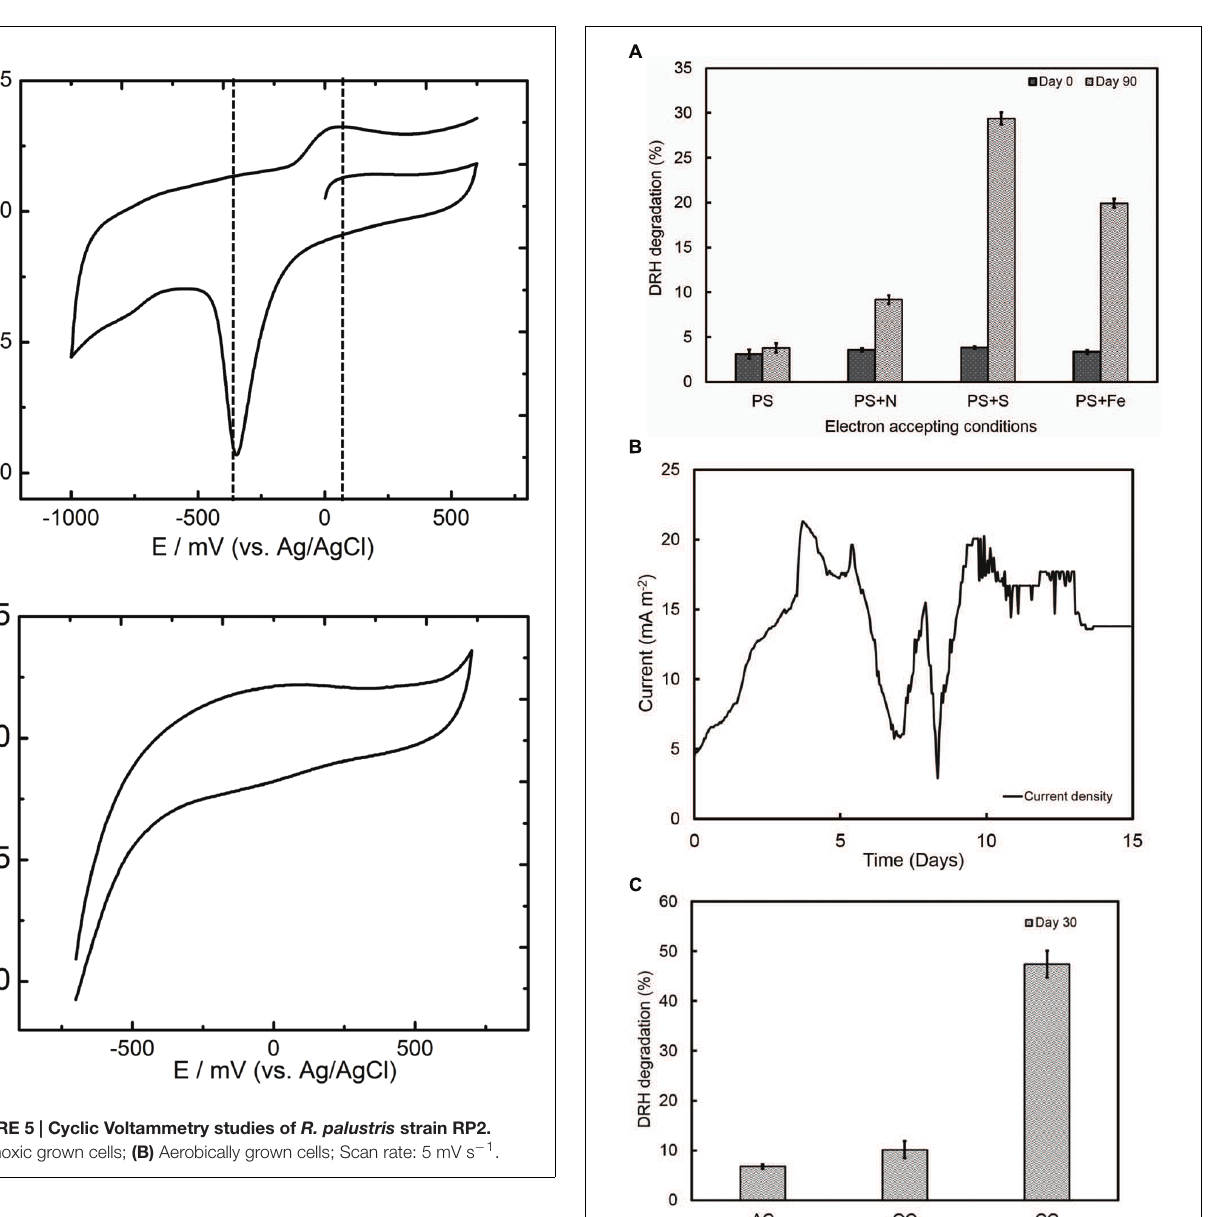
plays important role in extracellular electron transfer to insoluble metal oxides.